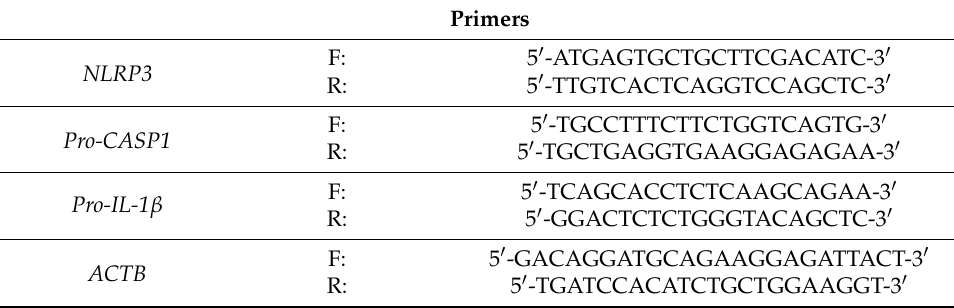
Table 1. Primer set sequences used for the RT-qPCR